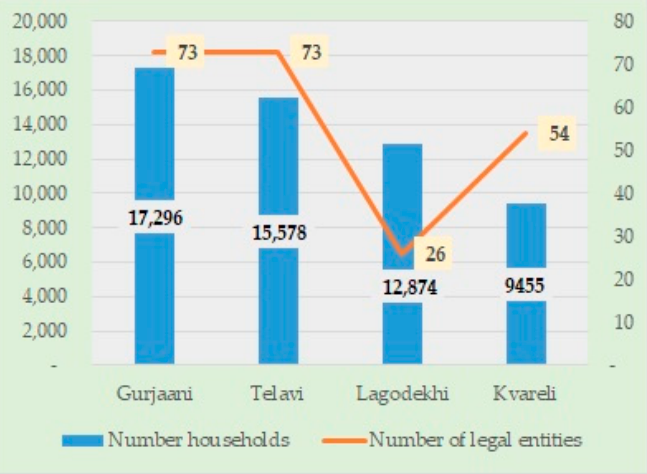
12 of 24 Figure 3. Population in targeted municipalities of Kakheti’s regions (source: Geostat, census 2014). Figure 4. Distribution of family holdings in targeted municipalities of Kakheti (source: Geostat, cen-